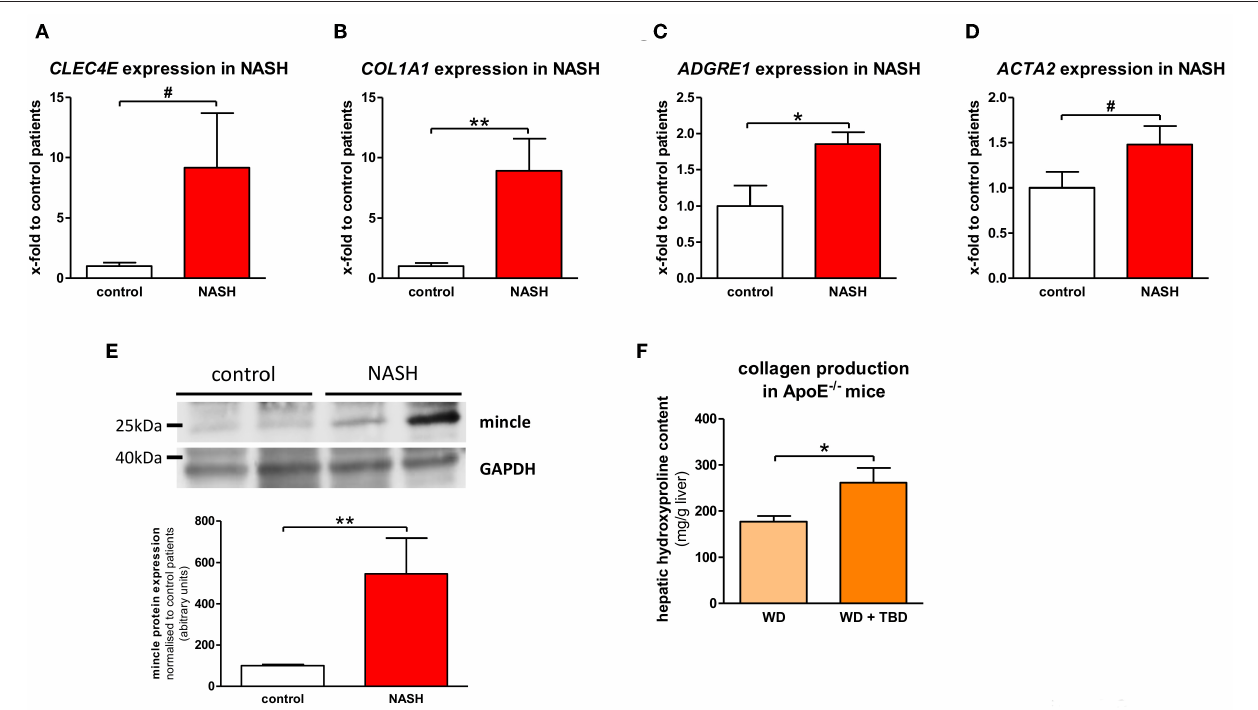
FIGURE 1 | Mincle in NASH. (A–D) Gene expression of mincle [gene CLEC4E ; (A) ], collagen [gene COL1A1 ; (B) ], EMR1 [gene ADGRE1 ; (C) ], and α SMA [gene ACTA2 ; (D) ] in liver samples of non-alcoholic steatohepatitis (NASH) patients and non-NASH controls (control). (E) Representative western blot showing protein levels of mincle in NASH patients and non-NASH controls and quantification of the Western blots. (F) Hepatic collagen production, shown by measurement of hepatic hydroxyproline content, in ApoE − / − fed WD with or without TDB treatment. * p < 0.05; ** p < 0.01; # p < 0.1 using unpaired t -test (A,D) or non-parametric Mann–Whitney U t -test (B,C,E,F) after testing for normal distribution.